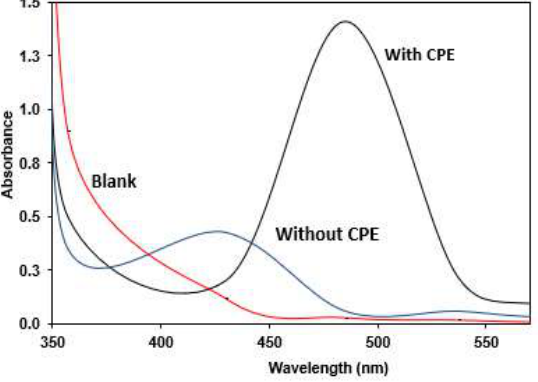
Figure. 1. Absorption spectra of 8 μg/ml of ISX treated DSD with and without CPE recorded against reagent blank, and the blank.